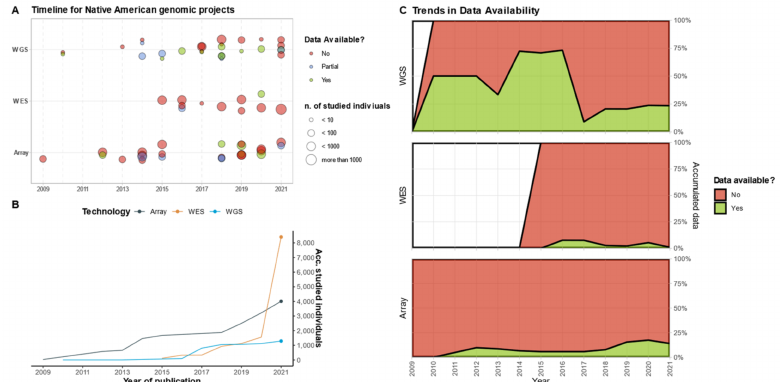
Figure 2. The history of NatAm genomics. ( A ) Projects across time. ( B ) Total increase in the number of NatAm individuals included in genomic studies. ( C ) Dynamics in NatAm data sharing. Only 1077 of the digital samples generated in NatAm genomic projects are readily available, with varying shares of availability by technology used (array, WES or